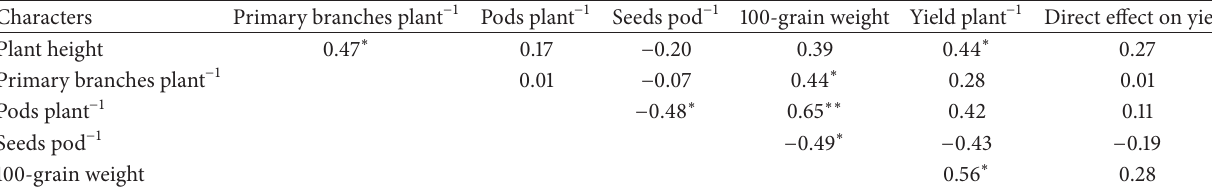
Table 2: Associations of different yield contributing characters and their direct effect on yield in ecological farming in lentil in two growing seasons (2010-11 and 2011-12).